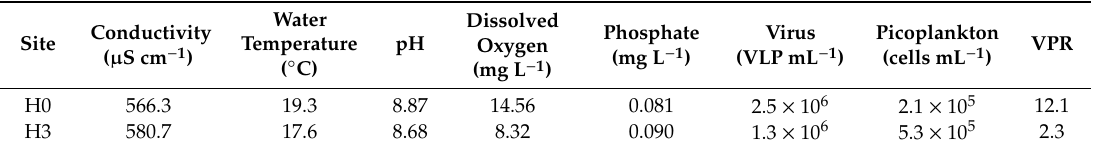
Table 1. Physicochemical parameters, viral, picoplankton abundance and virus to picoplankton ratio (VPR) determined for both